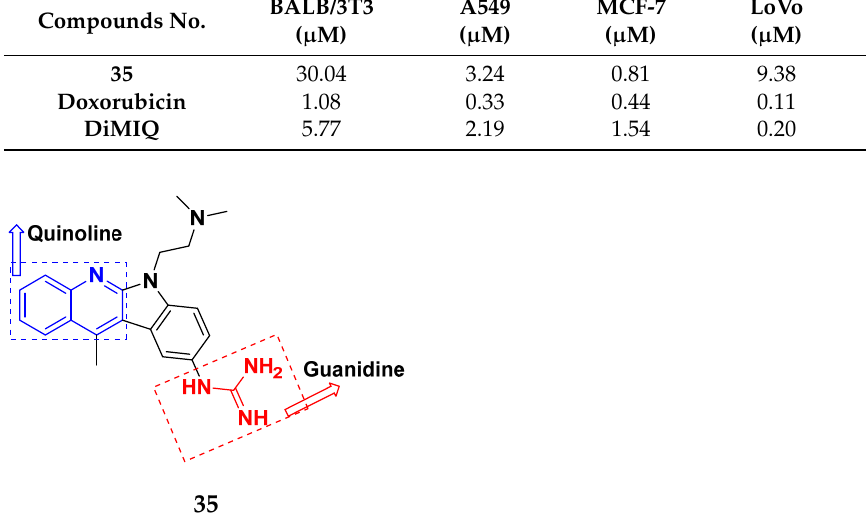
Table 29. In vitro cytotoxic activities of quinoline-pyrimidine based hybrid compounds 35 . Compounds No.